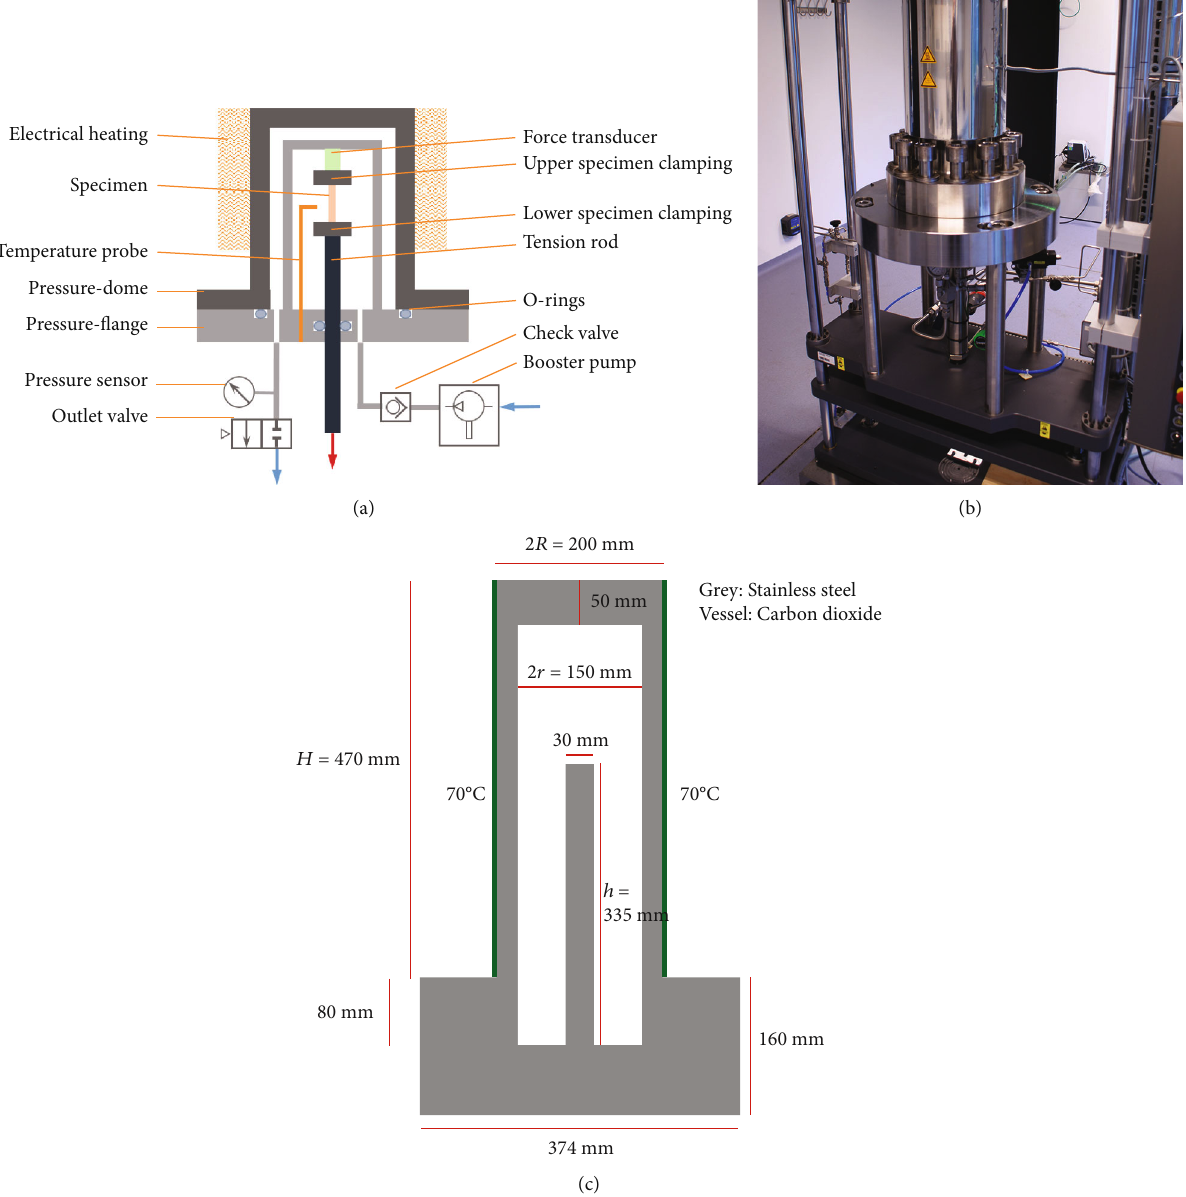
Figure 4: (a) Scheme and (b) photograph of the tensile creep tester. (c) Scheme and dimensions of the vessel of the creep test device with R = 100 mm , H = 470 mm , r = 75 mm , and h = 335 mm for the simulations at 70 ° C. Table 4: Thermal conductivity λ , density ϱ , and speci fi c heat capacity c Material λ at 100 ° C (W/(m K)) ϱ (kg/m 3 ) c Carbon dioxide 0.0224 Stainless steel (grade TP 316/316